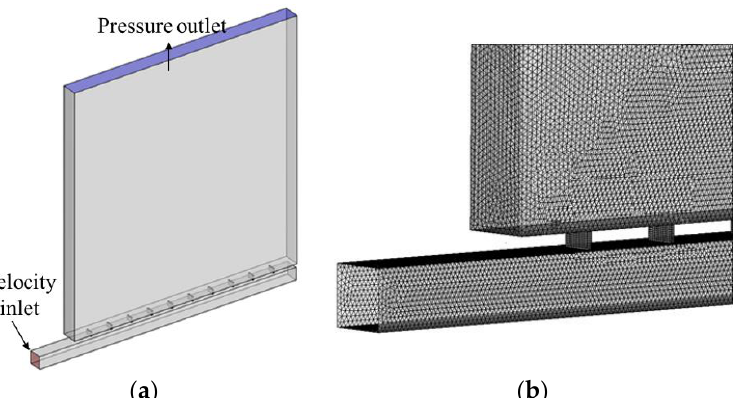
Figure 7. Numerical simulation of the longitudinal culvert filling–emptying system: ( a ) modeling and ( b ) meshing.